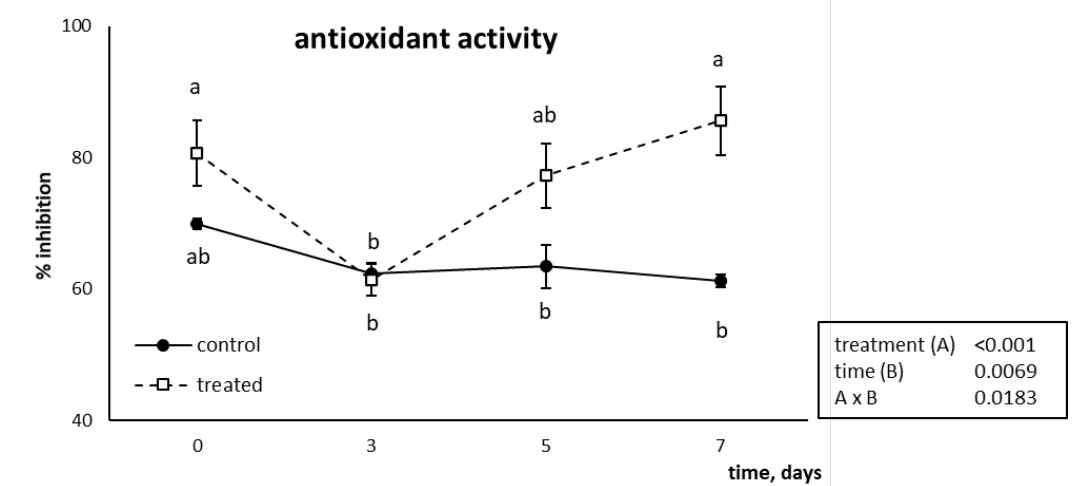
Figure 4. Inhibiting profile of ABTS (mean ± SE) from tomato fruit coated with tyrosol-enriched chitosan solution or left uncoated (control) for up to 7 days. Different letters indicate statistically significant differences, according to two-way ANOVA, followed by Tukey–Kramer post hoc test ( n = 3, p < 0.05). The results of two-way ANOVA are reported in the box.